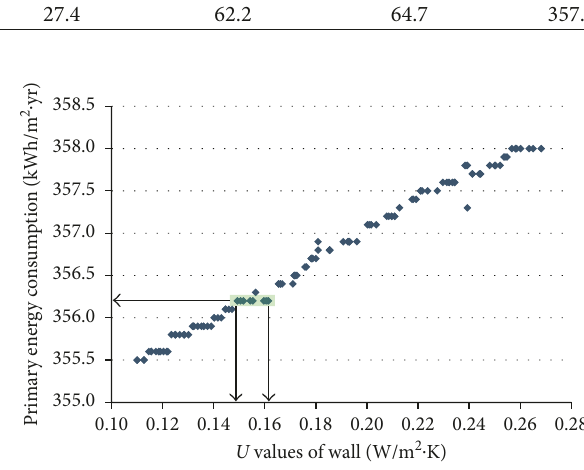
yr) for the target building. ·